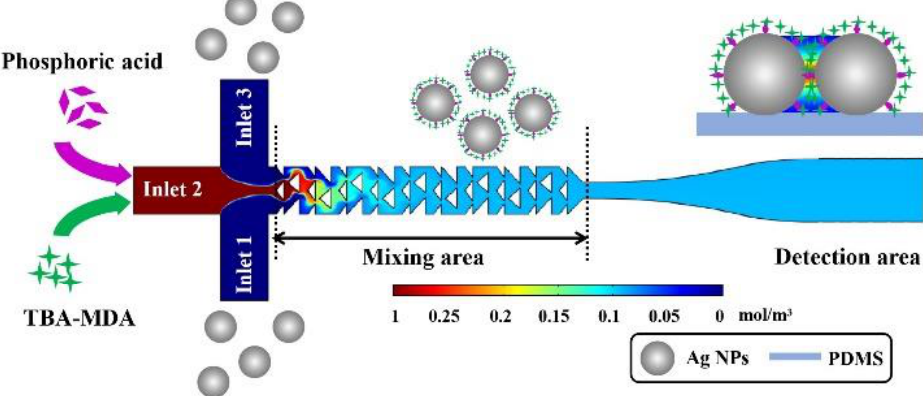
Figure 4. Schematic illustration of the process for highly sensitive detection of MDA.